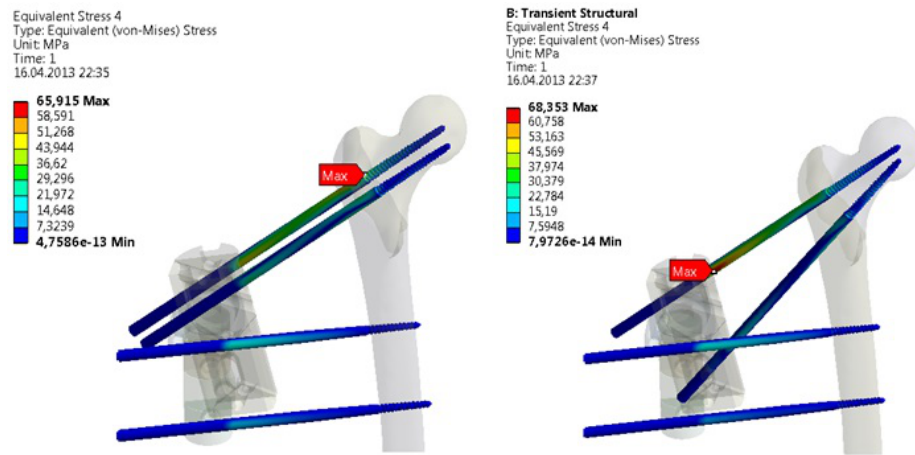
Figure 5. Demonstration of the maximum stress of proximal schanz screws.